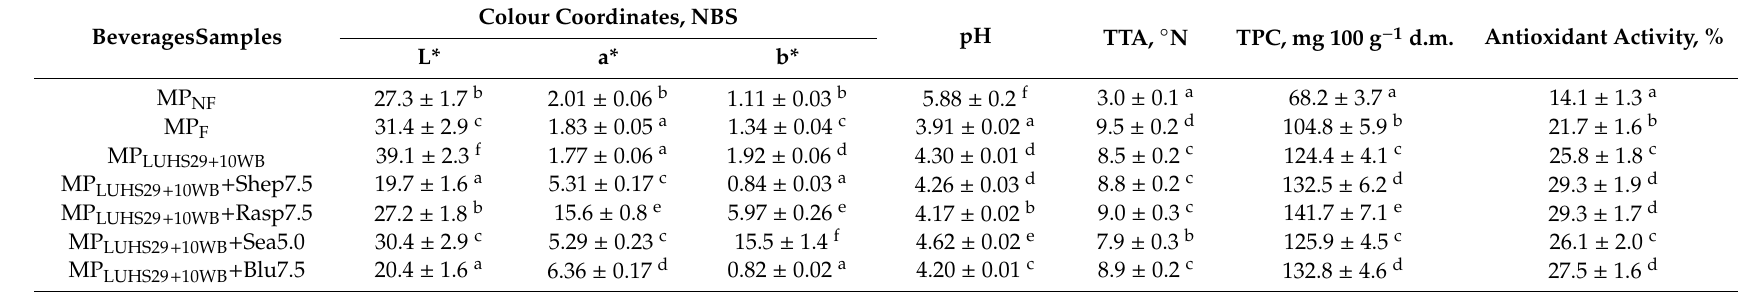
Table 10. Colour coordinates, acidity and antioxidant parameters of the prepared